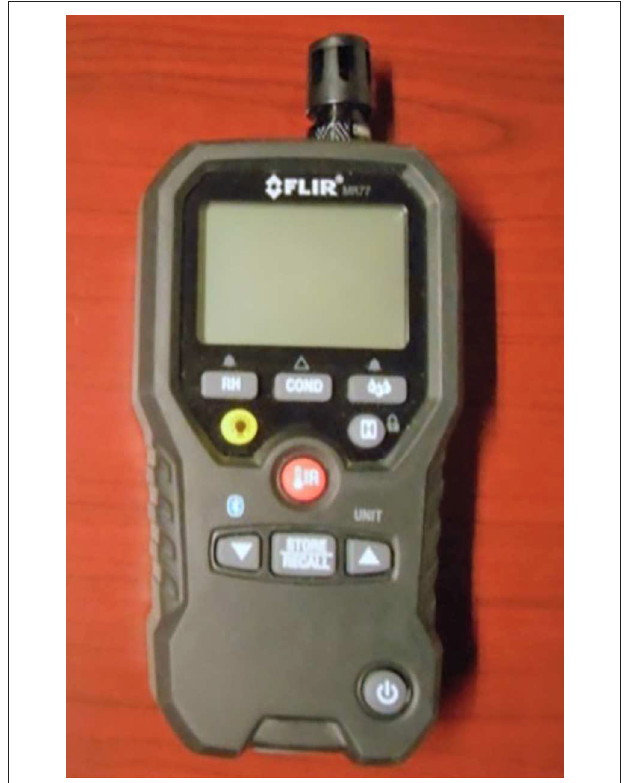
FIGURE 5 | FLIR MR77.